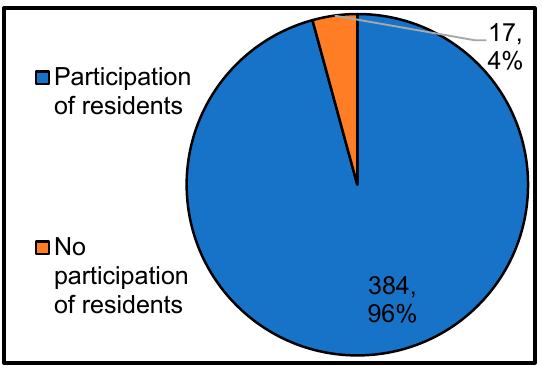
Figure 7. Presence or absence of participation of local residents, who are the shelter operating entities.